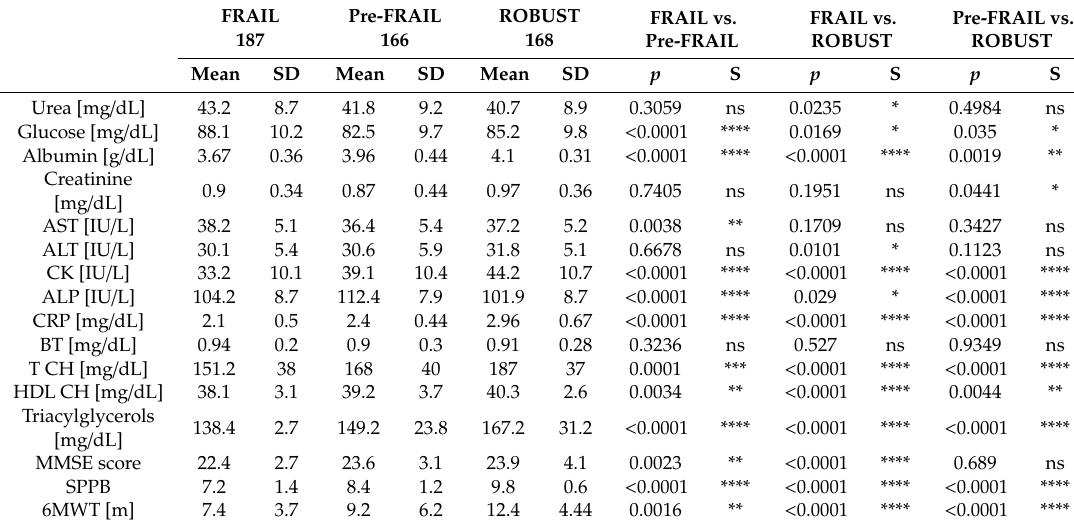
Table 3. Biochemical and metabolic parameters.